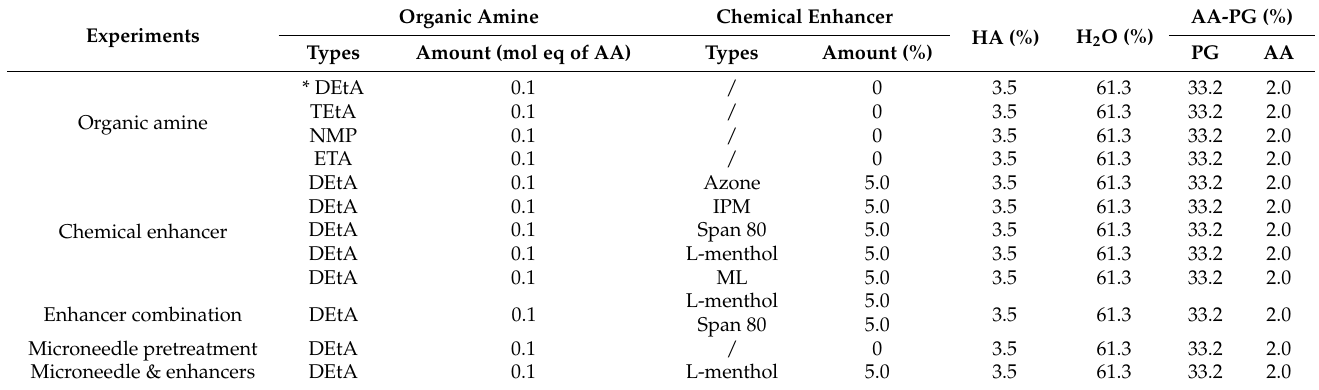
Table 2. Prescriptions of AA-loaded hydrogels containing organic amines and/or chemical enhancers.